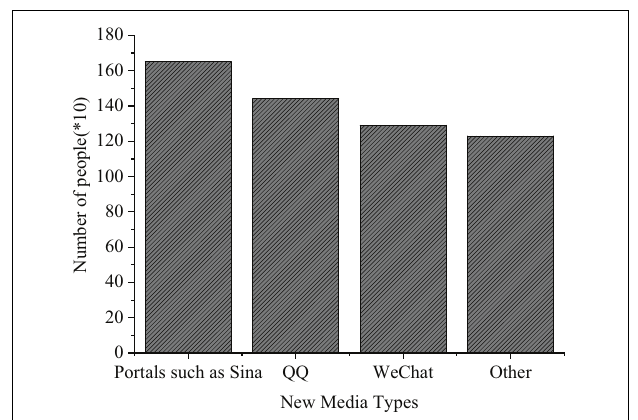
FIGURE 7 | Questionnaire Survey of the types of new media used.